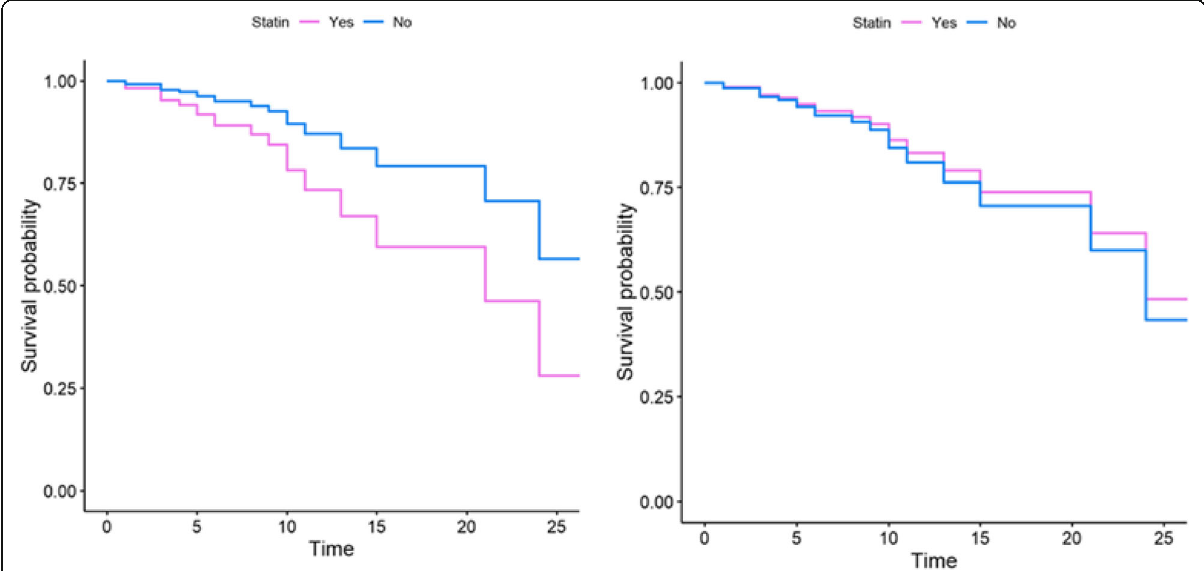
Fig. 4 Crude survival and propensity score-adjusted Cox plots comparing the survival time (in days) between the statin and non-statin groups. The plots highlight the difference between crude and propensity score-adjusted survival Cox regression plots for the statin and non-statin patient populations. These plots suggest that before adjustment (left plot), the statin group displayed a lower survival time, whereas after adjustment (right plot), statin users showed a higher survival probability; however, neither of these differences was